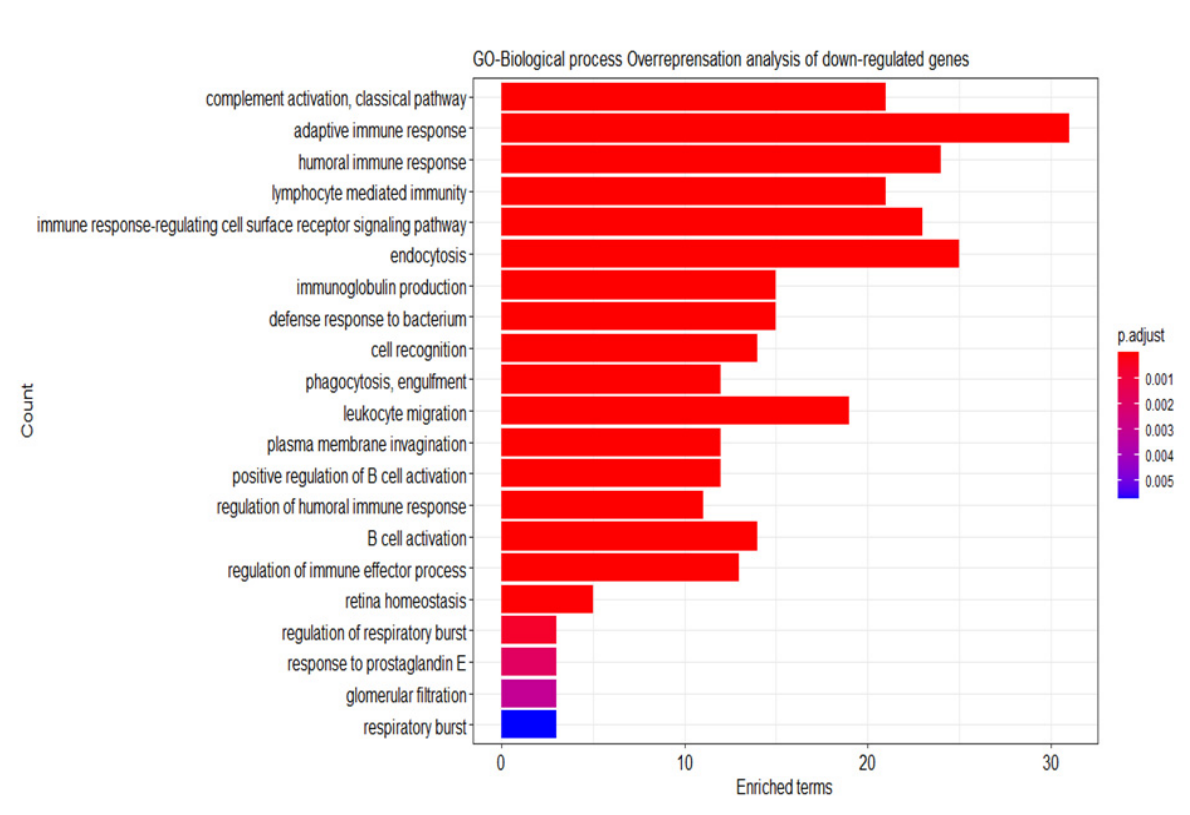
Figure 9. Overrepresentation analysis of the 59 downregulated genes by GO–biological process. The downregulated genes were mostly concentrated in the immune pathways, such as classical pathway of complement activation, adaptive immune response and humoral immune